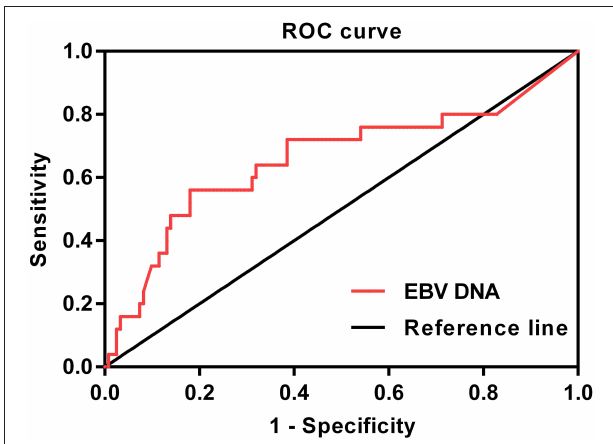
# Fisher exact test. * Correction for